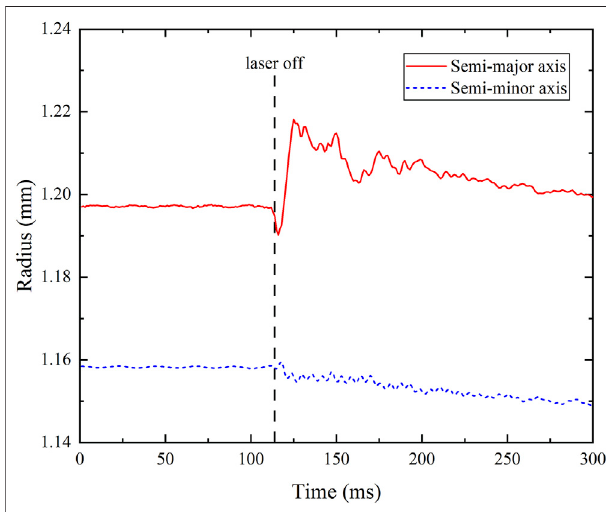
FIGURE 8 | Radius change after turning the upper laser